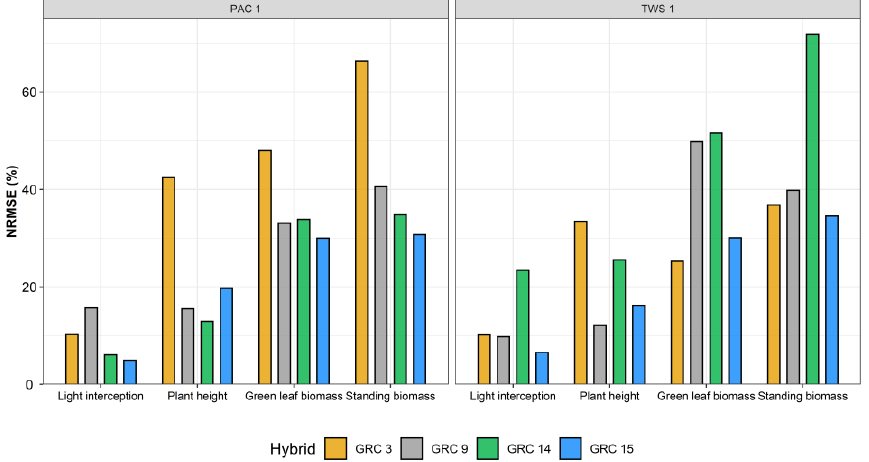
Figure 6. NRMSE values of the RF models obtained for each crop trait assessed in four hybrids grown at the two locations in PAC 1 and TWS 1. Note: lower values indicate higher estimation accuracies.